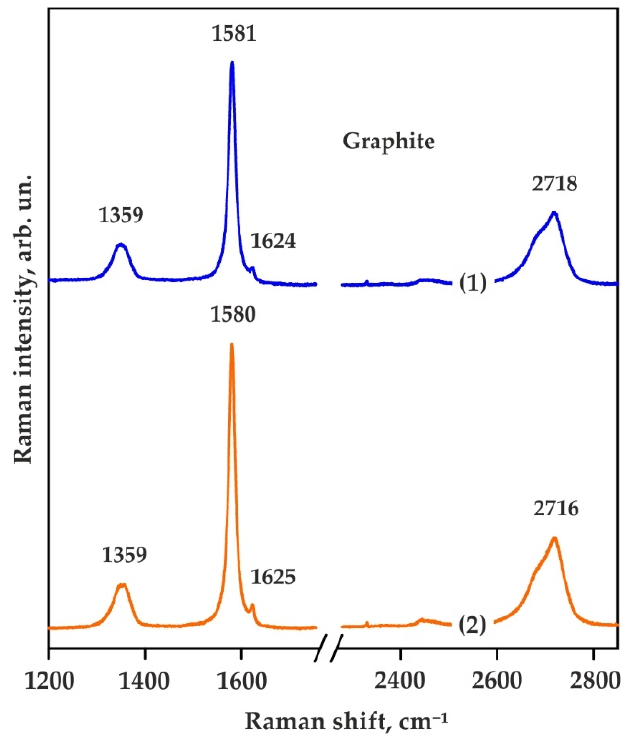
Figure 7. Representative Raman spectra of graphite: (1) 1150 °C; (2) 1250 °C. //: an interruption and continuation of the x-axis values; arb.un.: arbitrary unit.